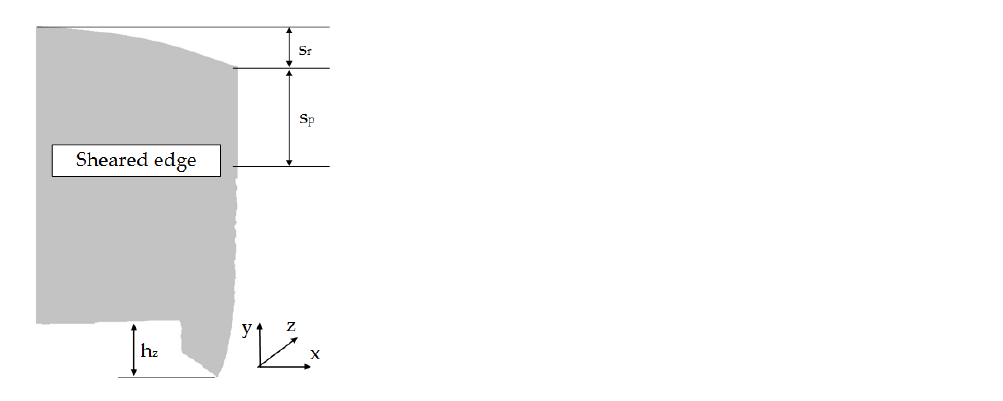
Figure 1. Experimental equipment and characteristic parameter definitions: 1—engine, 2—electrical system, 3—circular knives, 4—sheet stabilizer, 5—drive pedal, 6—high-speed camera, 7—threaded socket with a scale for adjusting the clearance, 8—cutting speed regulator, 9—knife overlap regulator, 10—scale for determining the diameter of cut discs for curvilinear contours, 11—sheet metal, 12—LED lamp, 13—PC for archiving measurement data, 14—auxiliary screen for data recording and analysis.